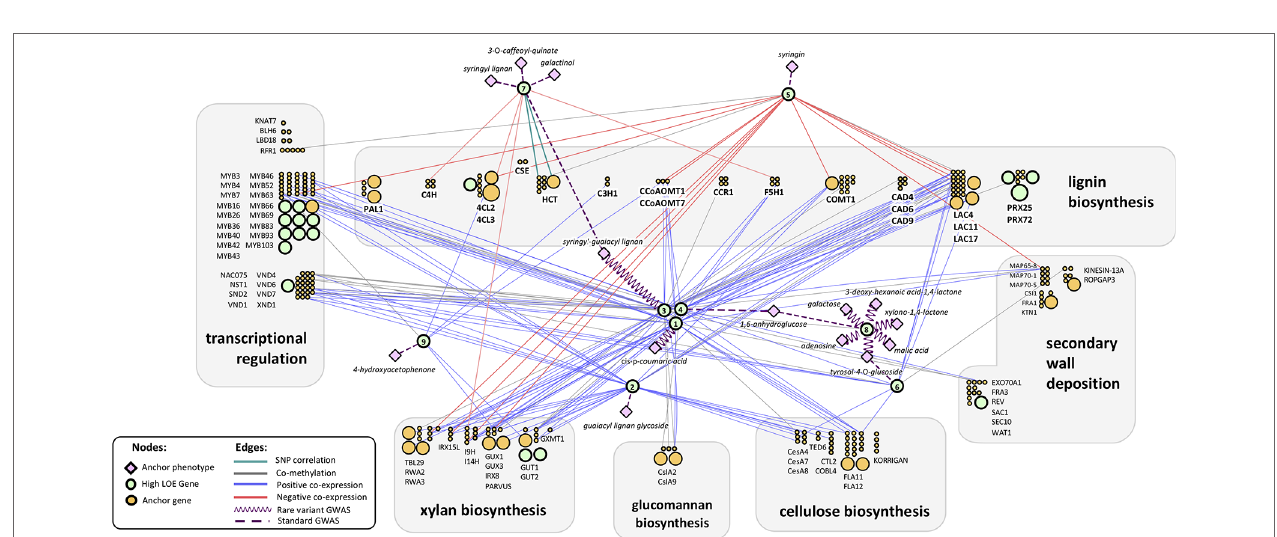
FIGURE 2 | Histograms of network intersect scores calculated by intersecting the observed and randomized LOE networks with GO-term functional networks. (A) Intersection with the global GO-term functional network resulted in a score of 0.4953 for the observed LOE network; intersect scores for randomized networks were ≤0.3701. (B) Intersection with the cell wall-specific GO-term functional network resulted in a score of 0.4806 for the observed LOE network; intersect scores for randomized networks were ≤0.3470.